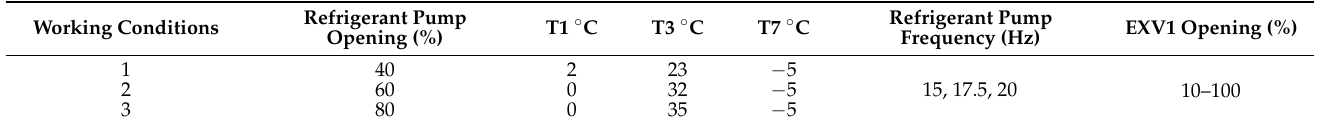
Table 4. Experimental